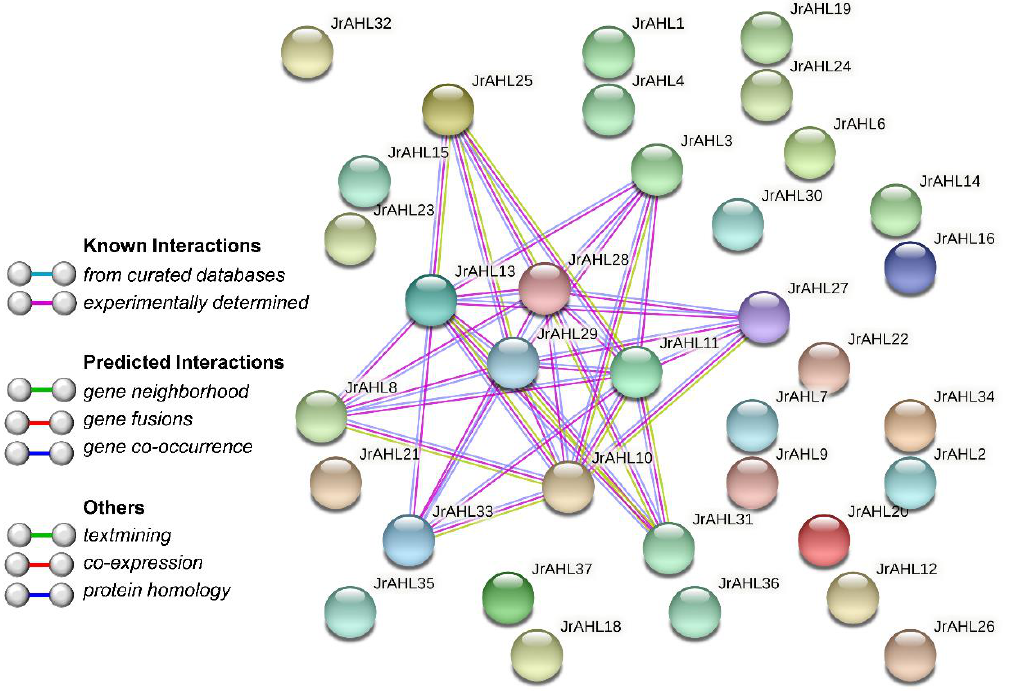
Figure 6. Predicted protein-protein interaction network of JrAHL protein. The network nodes represent proteins. The line color indicates the type of interaction evidence.